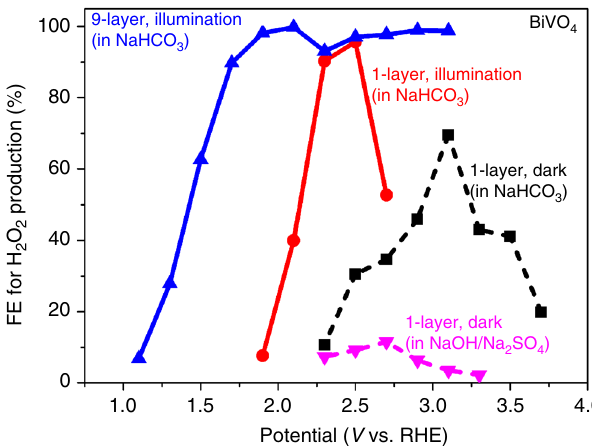
Fig. 4 The FE for BiVO 4 under both dark and illumination. FE vs applied bias for BiVO 4 under different conditions, including different electrolytes in darkness, same electrolyte between darkness and illumination, and different layers under illumination. The thicker BiVO 4 with light illumination in NaHCO 3 shows best performance for H 2 O 2 similar FE trend with increasing applied bias: the FE fi rst increases to a maximum value and then decreases. Or